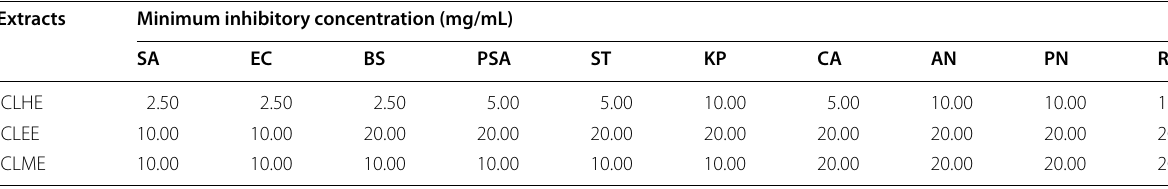
Table 3 Minimum inhibitory concentration of I. trichantha extracts